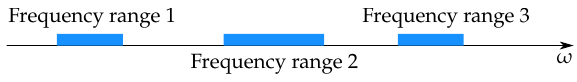
Figure 1. Schematic of frequency-band